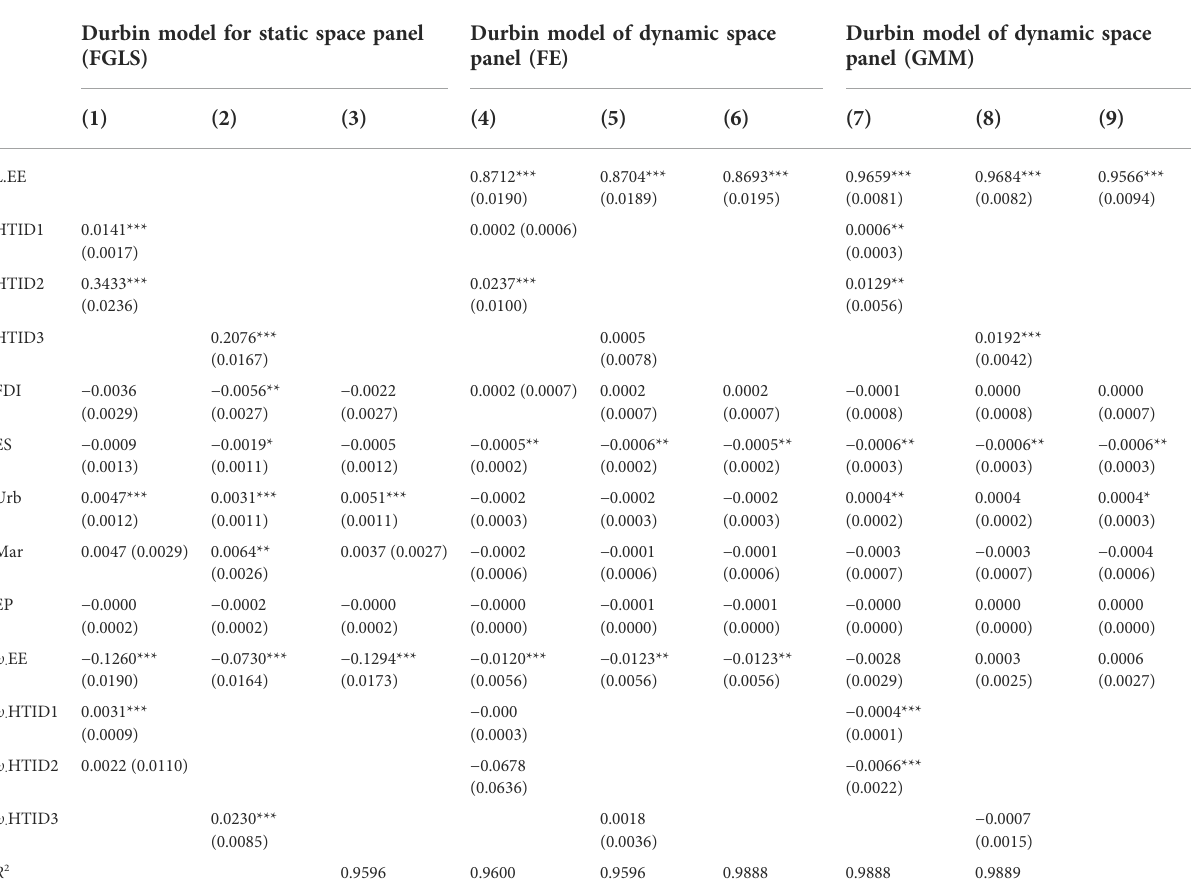
TABLE 3 Impact of HTID on energy ef fi